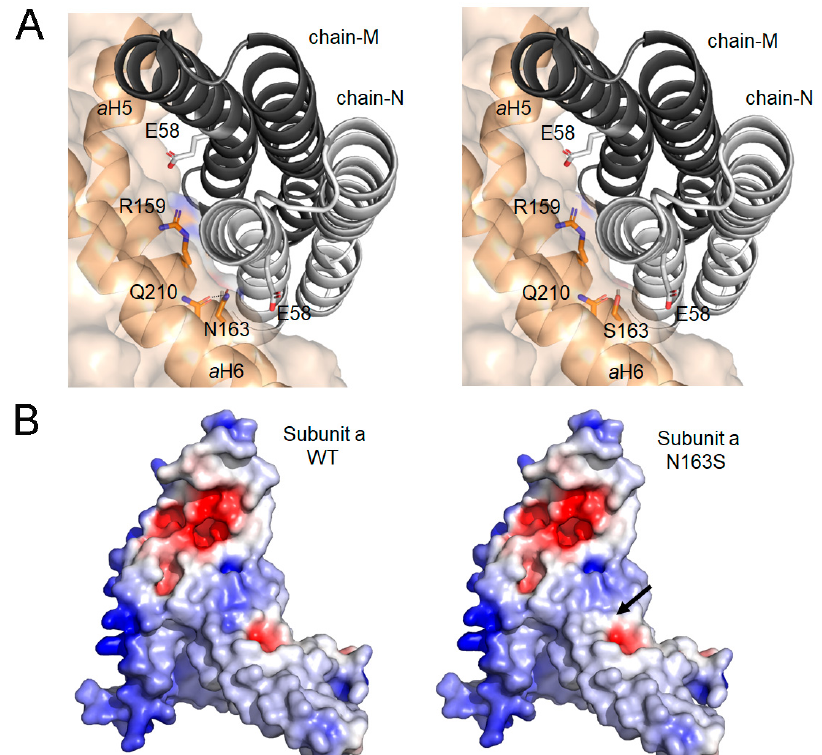
Figure 7. The impact of N163S mutation in the structural model of the mouse ATP synthase subunit a: ( A ) detail of the interface view between the c-ring and a subunit for WT (left panel) and p.N163S (right panel). Chain-N and chain-M of c-ring are displayed with cartoon representation (light and dark gray, respectively). Subunit a is displayed as surface with cartoon representation of the secondary structure elements, helices aH5 and aH6, implicated in the interaction. Relevant residues are represented as sticks and CPK colored; and ( B ) impact of p.N163S mutation on the electrostatic surface potential (ESP) of mouse subunit a. ESP for wild-type (left panel)) and its N163S (right panel) variant was calculated at pH 7.4 and 150 mM of salt using the APBS-PDB2PQR software suite (https://www.poissonboltzmann.org/ (accessed on 17 November 2022)) and then plotted using PyMOL. Position of N163S mutation is indicated by a black arrow. The range of change potential is − 5 (red) to +5 (blue). The structural model of mouse subunit a (AF-P00848) was obtained from AlphaFold protein structure database [66,67].